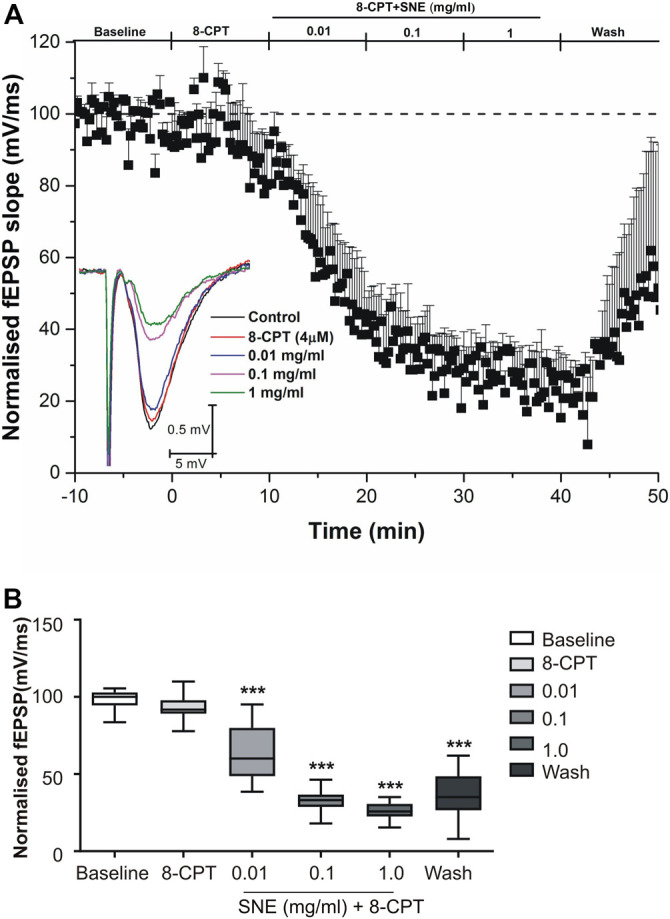

(A) Administration of 8-CPT (4 µM) before SNE (0.01, 0.1 and 1.0 mg/ml) on slope of fEPSPs in rat hippocampal slices after a stable baseline perfused with normal aCSF. (B) The box and whiskers graph is the total effect calculated form the AUCs of the graph above it. Data is mean ± SEM (n = 3). ***p < 0.001 compared with baseline, one-way ANOVA followed by a Dunnett’s multiple comparison test.